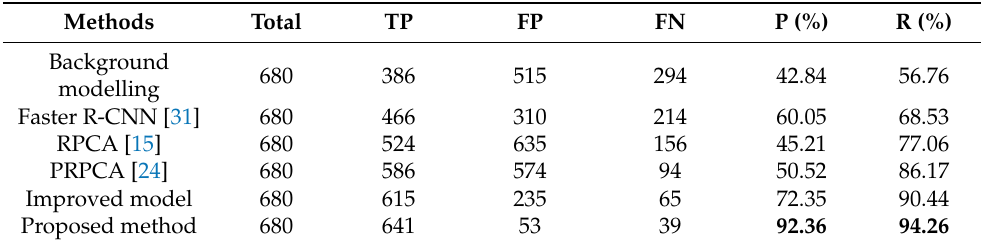
Table 1. Comparison of results of different methods.